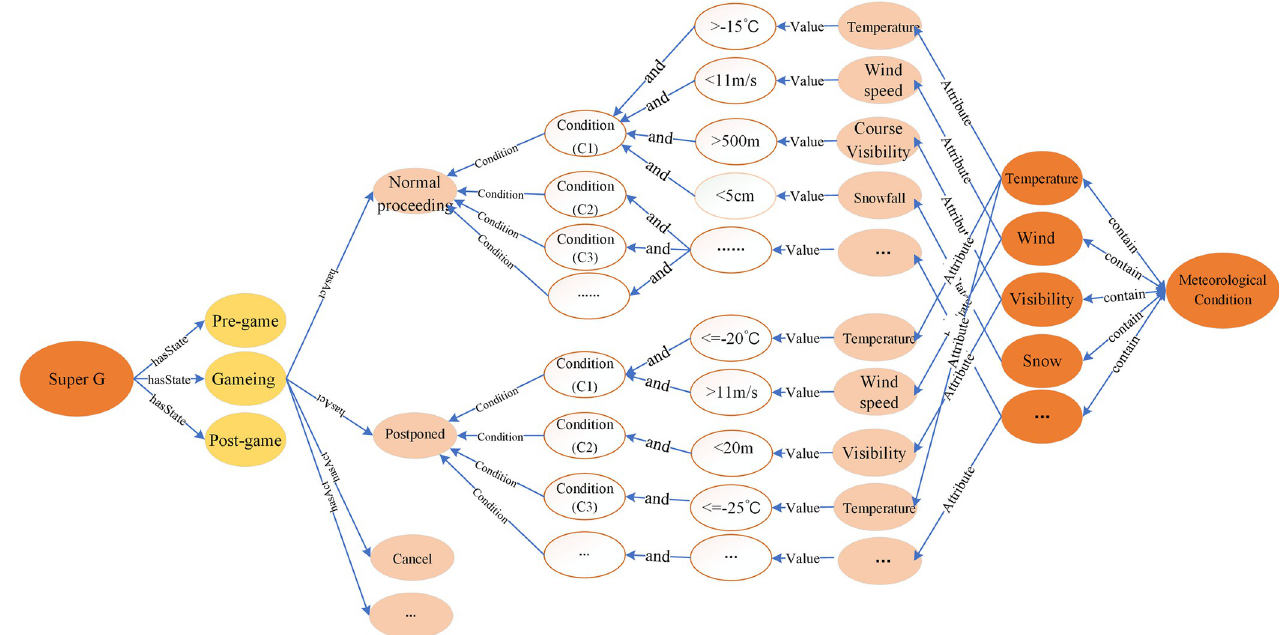
Fig 4. Diagram for the composite